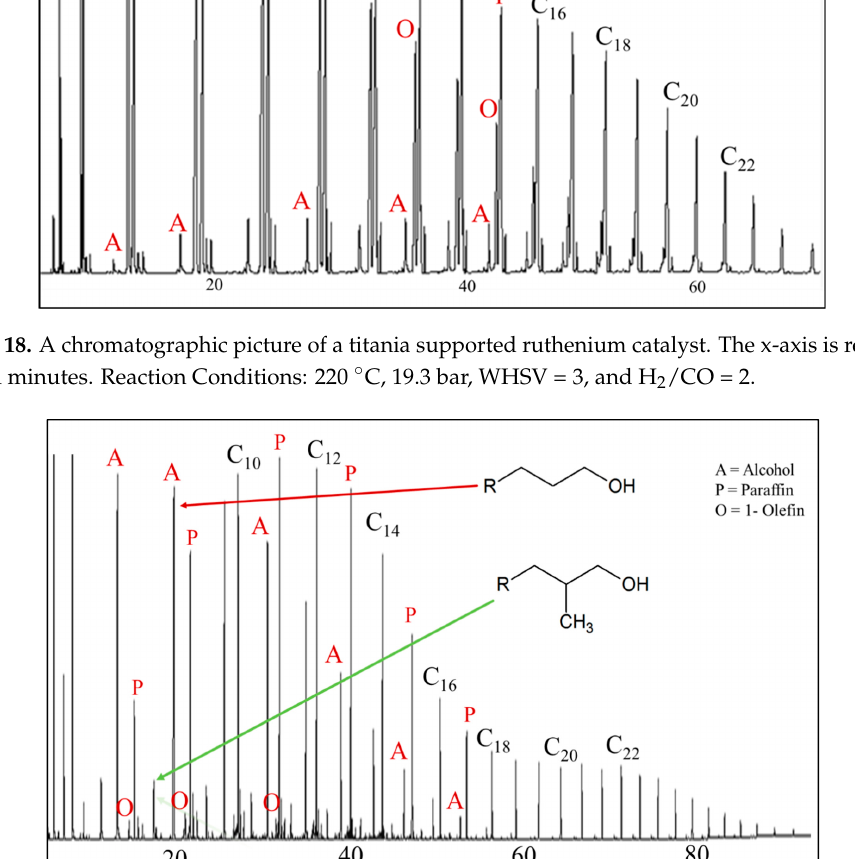
Figure 20. A chromatographic picture of potassium promoted iron catalyst. The x-axis is retention time in minutes. Reaction Conditions: 270 °C, 12.1 bar, WHSV = 2, and H 2 /CO = 0.7.